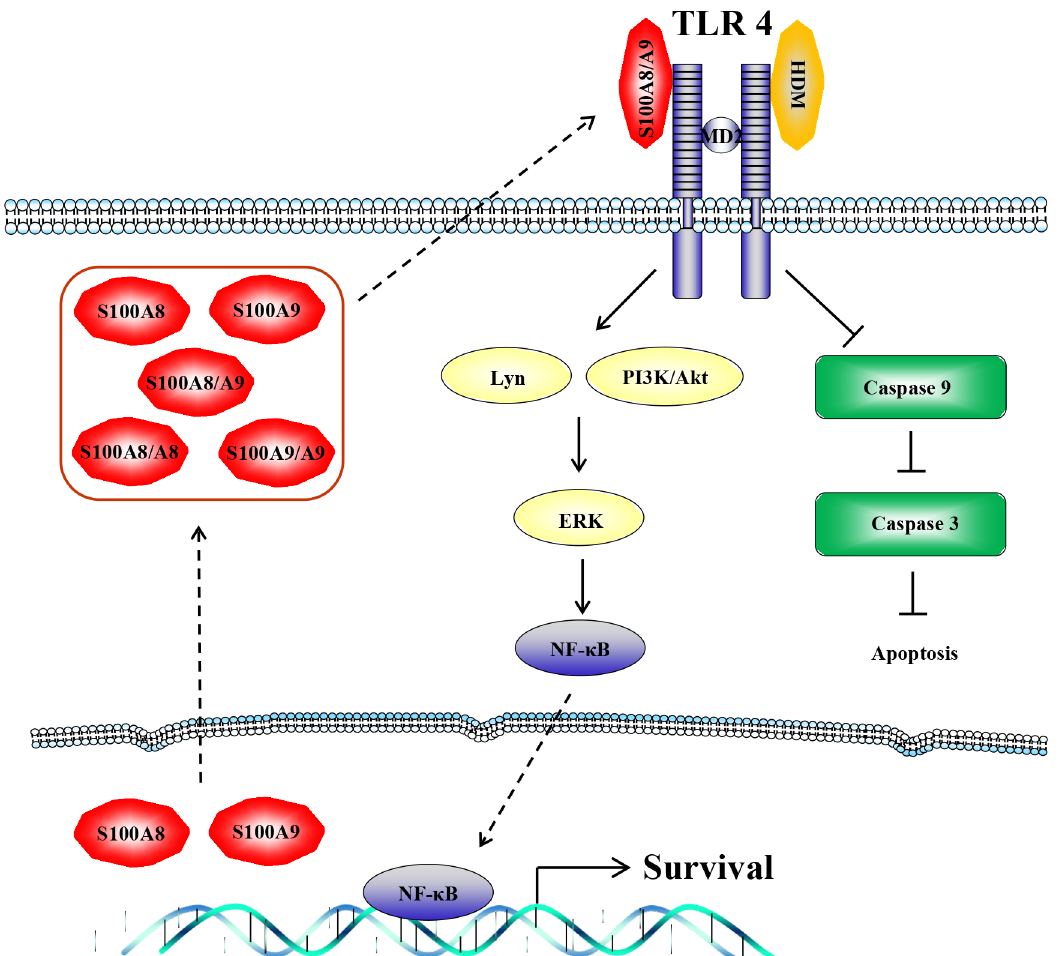
Fig 7. The proposed anti-apoptotic signaling pathway induced by DP in normal and asthmatic neutrophils. Anti-apoptotic signaling due to DP, S! 00A8, and S100A9 involves TLR4, Lyn, PI3K, Akt, ERK and NF- κ B, and is associated with suppression of procaspase 3 and procaspase 9 cleavage.